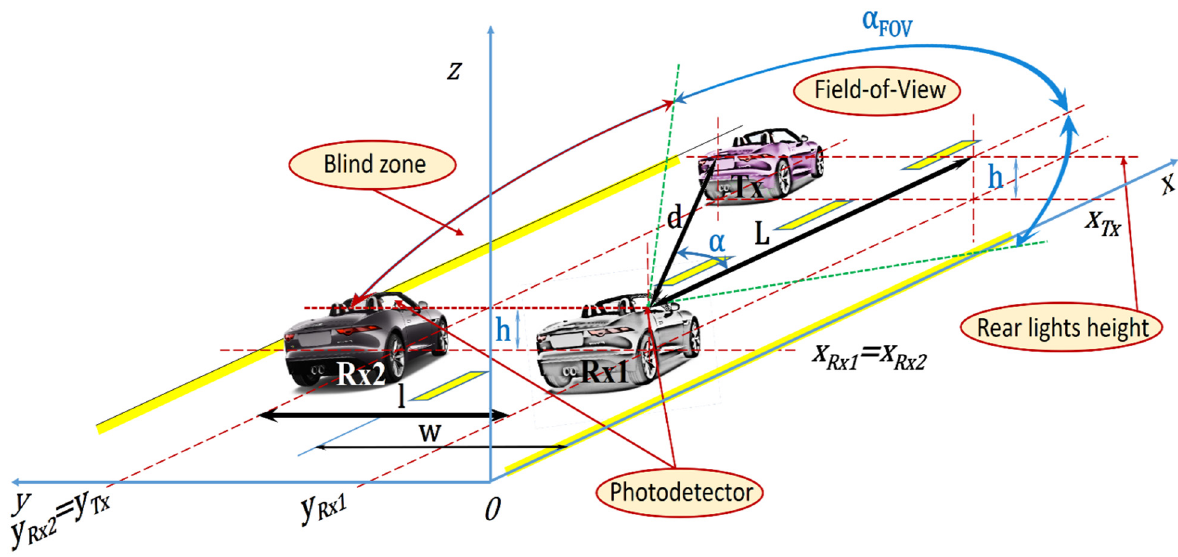
Figure 1. V2V communication scenarios: ( a ) Case one, with the communication established between two vehicles on adja- cent lanes; and ( b ) case two, with the communication established between two vehicles on the same lane.